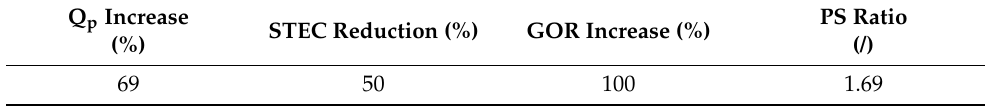
Table 5. Gain obtained with the integrated DCMD – VMD flowsheet.